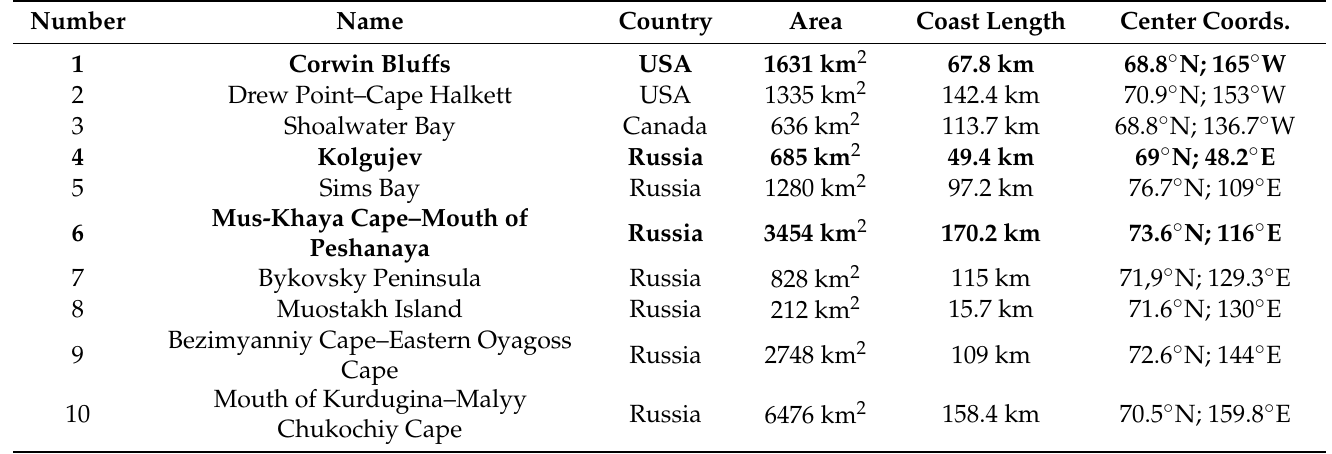
Table 1. Regions of interest analyzed within the framework of this study. Information about the region’s name, country, analyzed area, length of the present coastline and the center coordinates (coords.) per area of interest (aoi) are provided. Validation sites are marked in bold